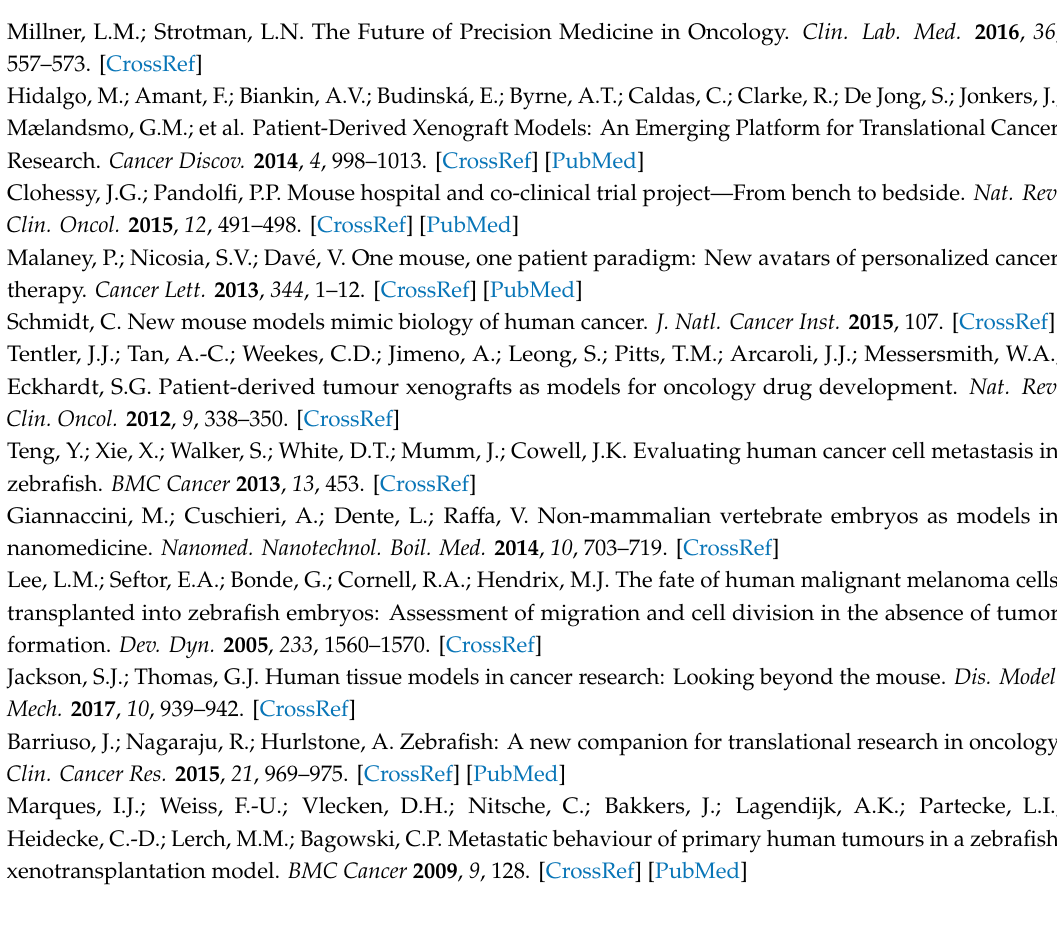
Table S1: Summary table of drugs used in the study, Table S2: Chemotherapy protocol used in the study, clinical dose, corresponding plasma equivalent concentration (EPC) and concentrations tested in the zebrafish toxicity study (Figure 1), Figure S1: H&E-stained sections of zebrafish embryo 2 days after receiving colon tumor tissue xenograft (A1–A2) and normal colon tissue xenograft (B1–B2) from the same patient, Figure S2 Co-clinical trial, Video S1: Patient cancer cells engraftment into zebrafish embryos 2 days after